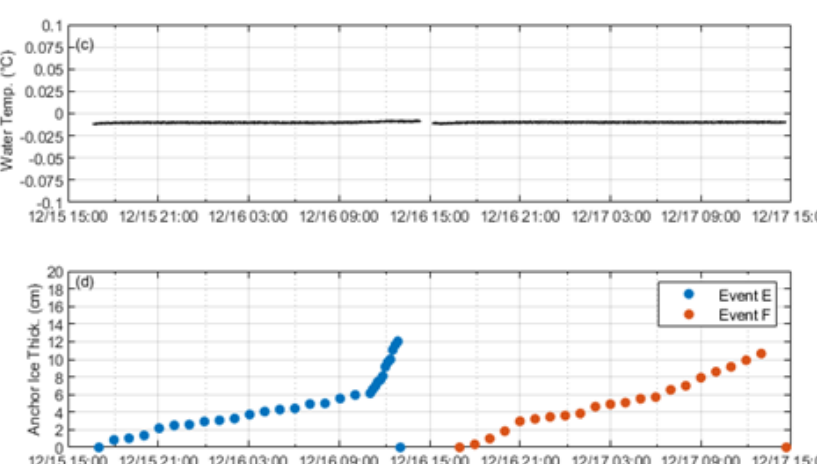
Figure 8. Time series of results of DEP-4 showing (a) air temperature and incoming solar radiation, (b) water depth at the WSC gauge #05DF001, (c) water temperature on the substrate, and (d) anchor ice thickness above the substrate for events E and F.